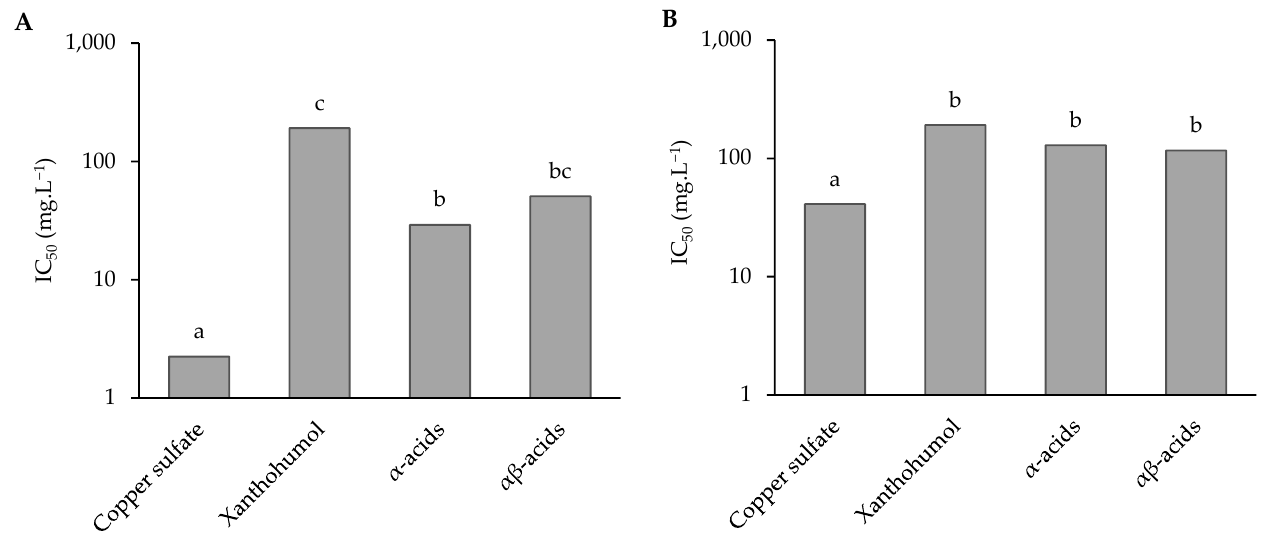
Figure 5. Half maximal inhibitory concentration (IC 50 ) values of hop main compounds and copper sulfate on P. infestans mycelial growth ( A ) and germination ( B ). Different letters represent significant differences.